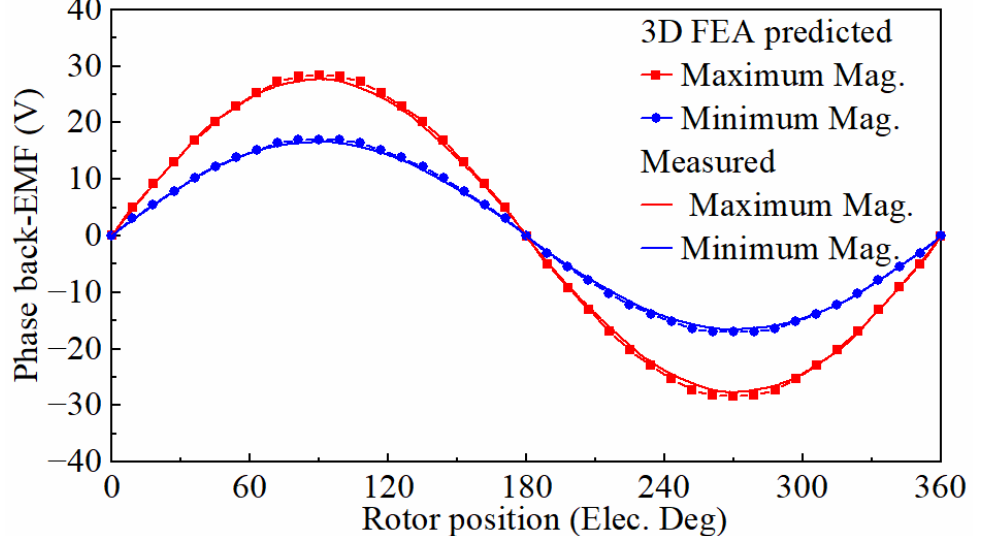
Figure 19. No load back-EMF in the maximum and minimum magnetization states.